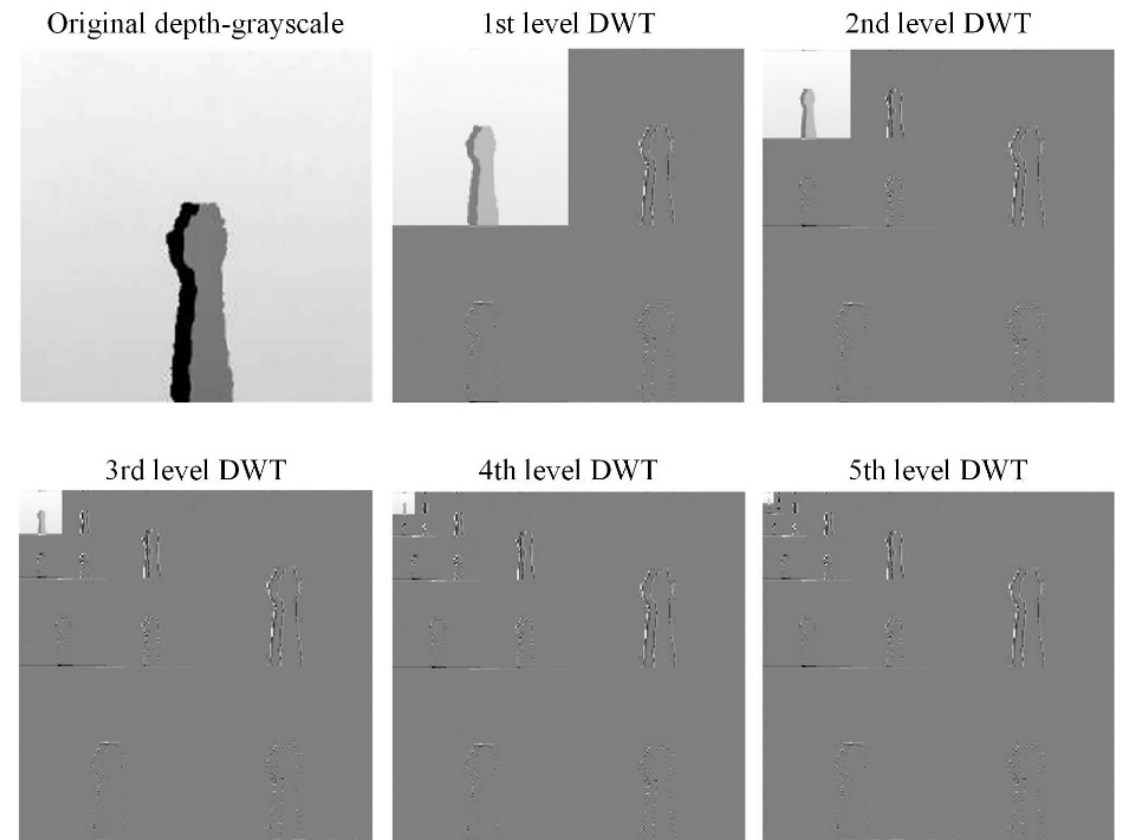
Figure 8. Coefficient derivation process of 5-level DWT decomposition on sensing data of the depth grayscale modality of the hand gesture action.